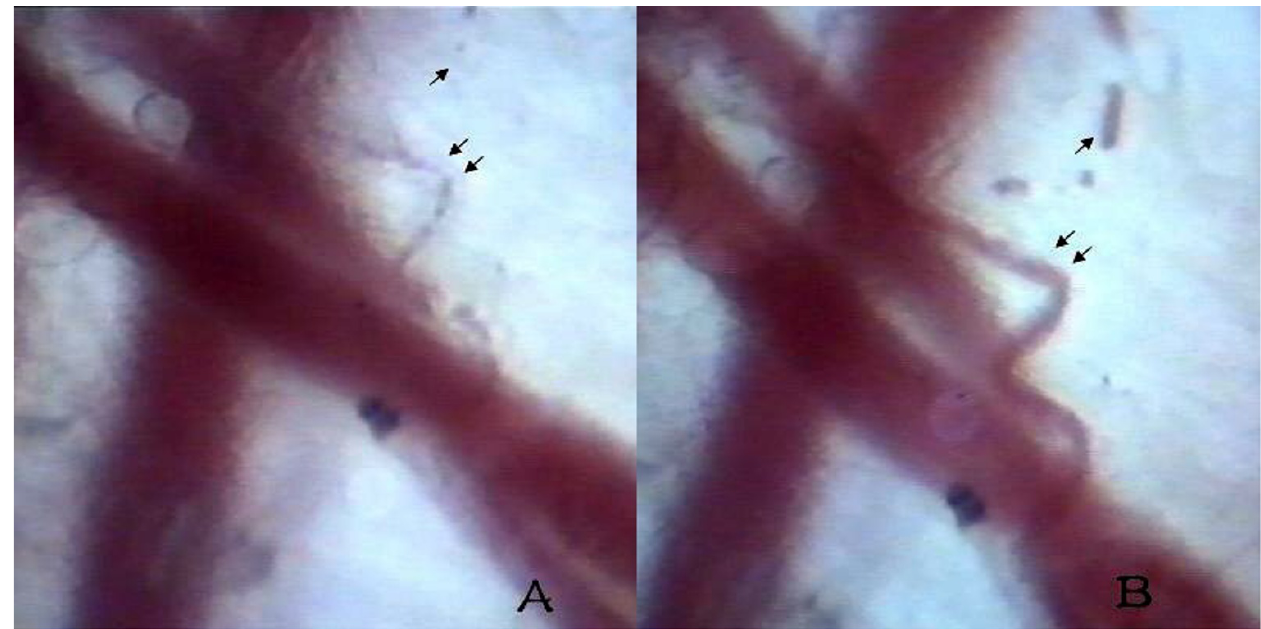
Figure 2 Comparison of photographs at different hours . A comparison of photographs documenting CSTI in the microcirculation of the rabbit ear treated with PRP extracts, in the baseline conditions (A), and within 5 hours (B) of reperfusion. Post-CSTI microvascular perfusion stopped in some microvessels (A, arrow). Blood flow decreased significantly with the evidence of the increased capillary diameter (B, arrow) and the reflow phenomenon (B, double arrow). (×640).